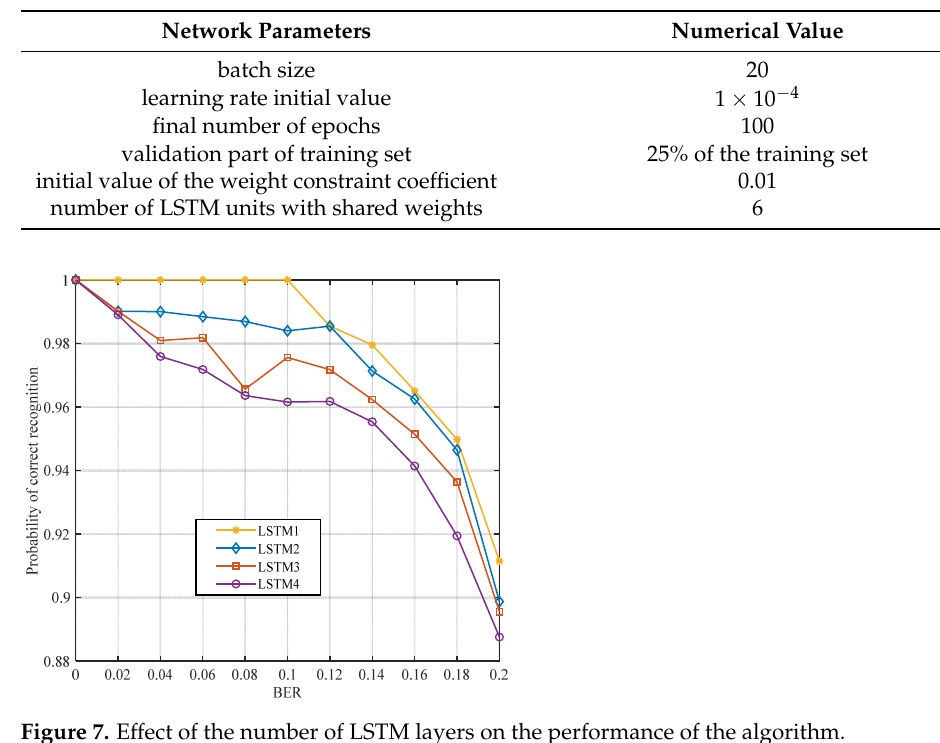
Figure 9. Effect of the number of CNN layers on the performance of the algorithm. Figure 10. The effect of the number of cells of LSTM on the performance of the algorithm. P r ob a b ilit y o f c o rr ec t r ec ogn iti on 0